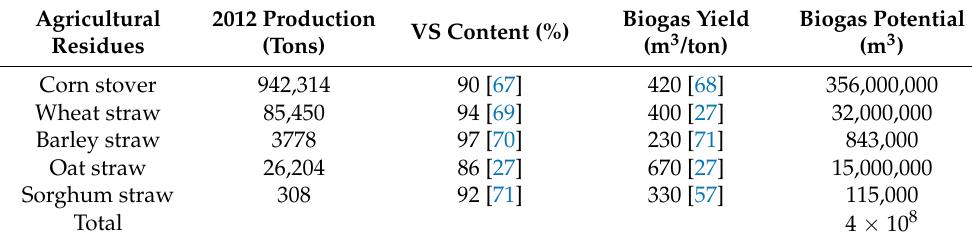
Table 2. Biogas production potential from agricultural residues in New York